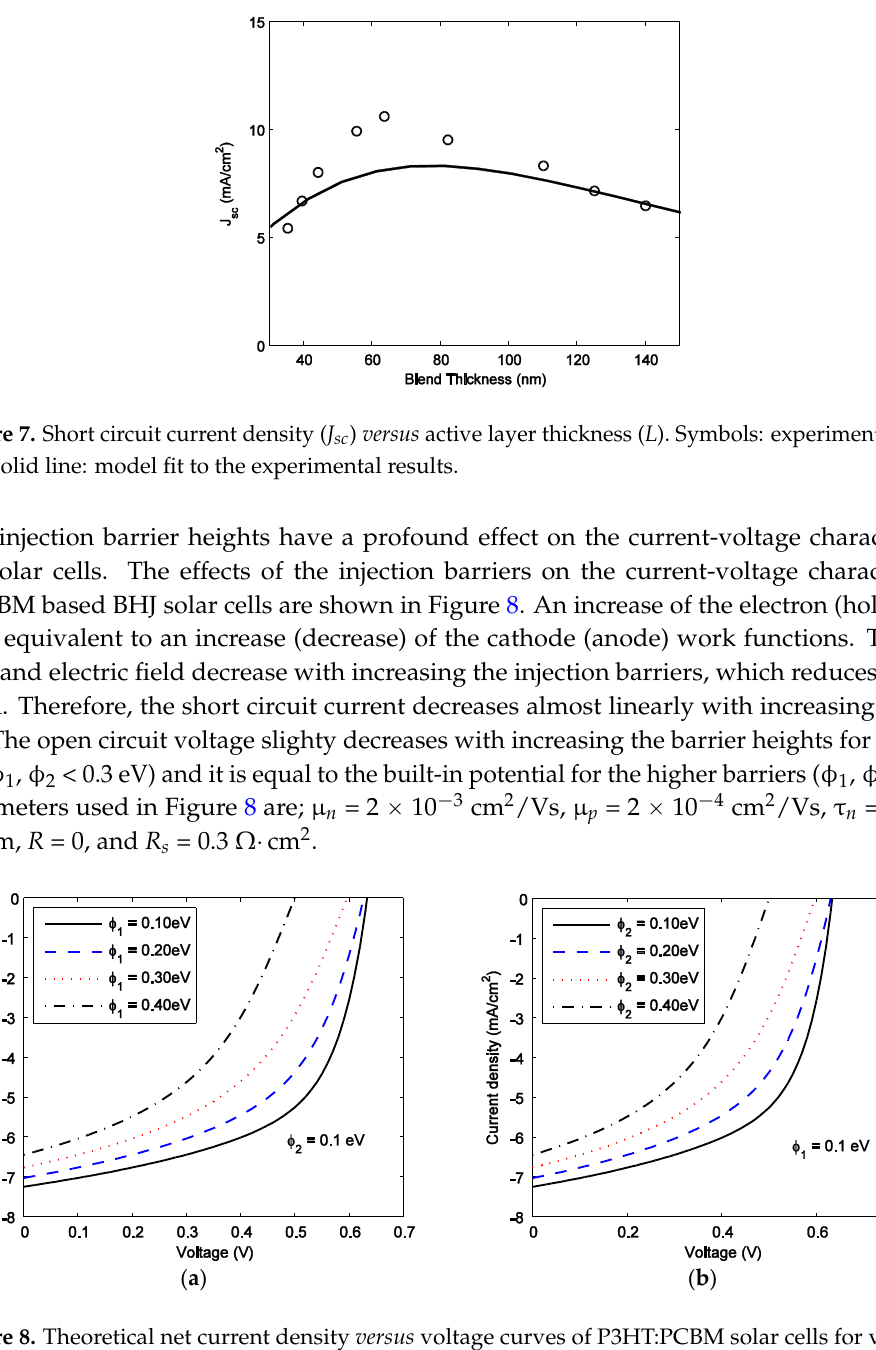
( b ) Figure 9. Theoretical current-voltage characteristics of P3HT:PCBM solar cells for ( a ) varying electron mobility with µ p = 2 × 10 −4 cm 2 /Vs and ( b ) varying hole mobility with µ n = 2 × 10 −3 cm 2 /Vs. Carrier lifetimes are:  n =  p = 20  s. Most of the incident photons are absorbed near the front contact ( x = 0) and thus the photogenerated free electrons have to travel relatively longer distance than the photogenerated holes. Therefore, the efficiency of BHJ solar cells should be more prone to the electron lifetime than to the hole lifetime. The effects of τ n and τ p on the J-V characteristics of a 230 nm thick P3HT:PCBM solar